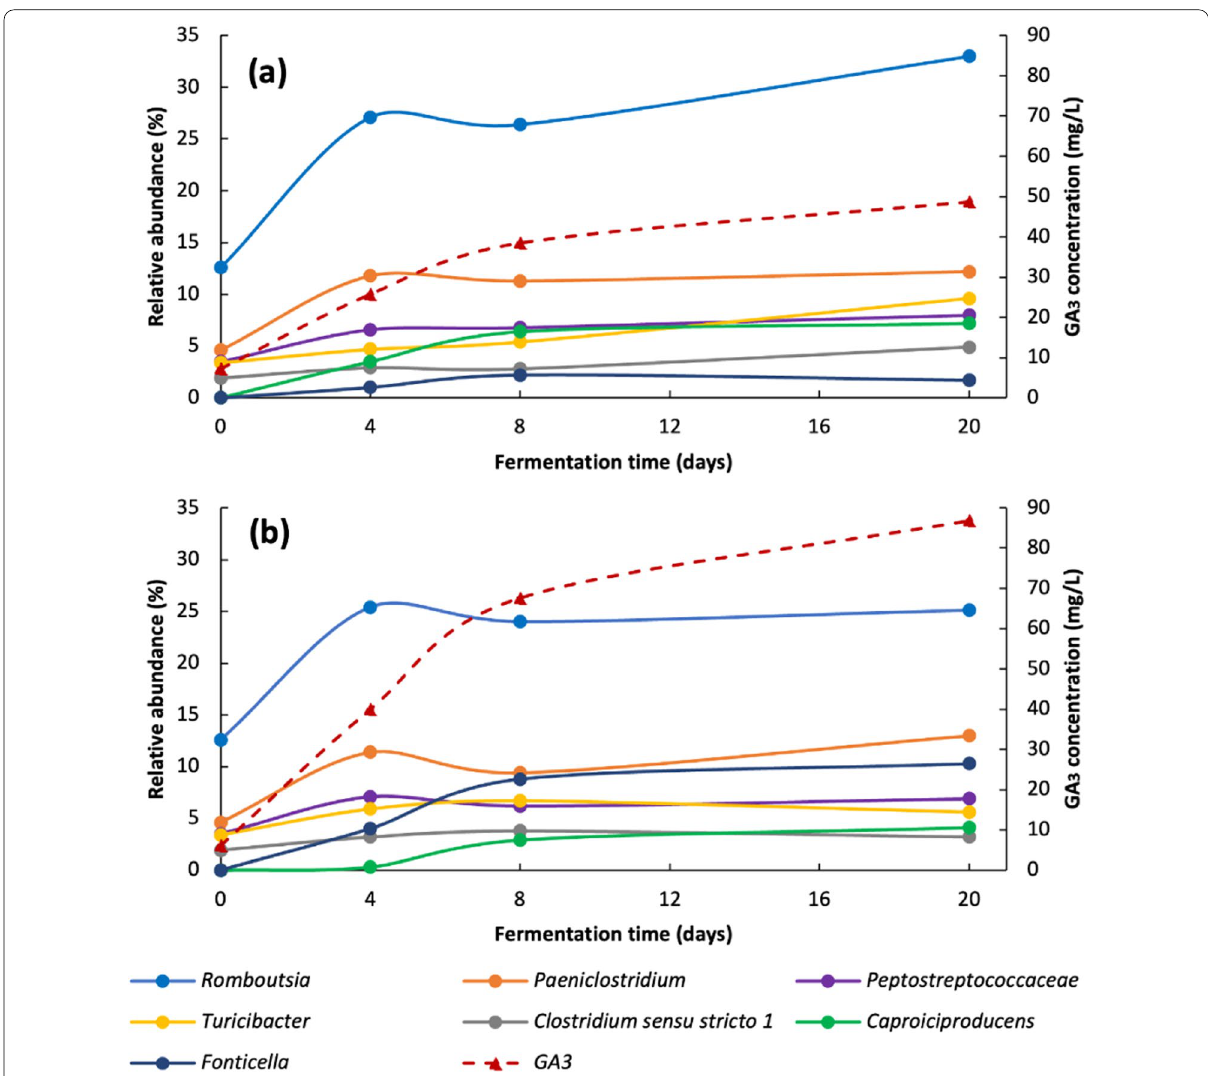
Fig. 3 Relationship between the production pattern of GA 3 and the microbial community abundance behavior at pH 5.5 ( a ) and 6.5 ( b